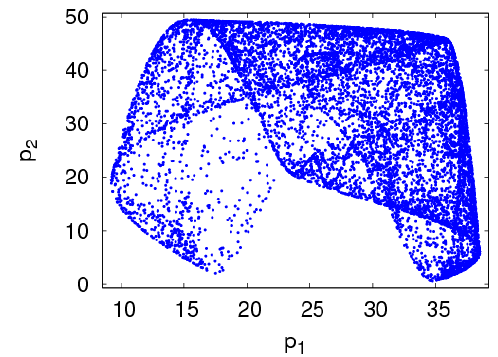
Figure 7. Chaos attractor of the dynamic system (6) with 𝛼 (cid:2869) = 0.013, 𝛼 (cid:2870) = 0.015 .